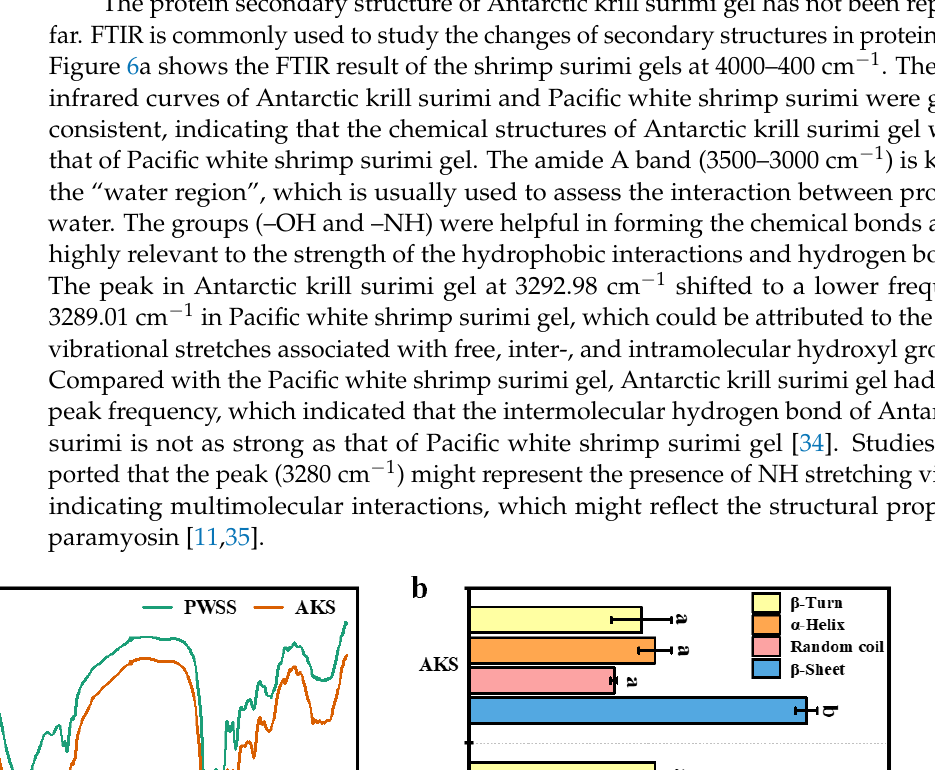
11 of 17 Figure 5. Protein patterns and gray value of Antarctic krill and Pacific white shrimp surimi (gels): ( a ) SDS-PAGE pattern, ( b ) grayscale map; ( c ) gray value of the top of the lane, ( d ) gray value of myosin heavy chain, ( e ) gray value of paramyosin, ( f ) gray value of actin, ( g ) gray value of troponin T, and ( h ) gray value of myosin light chain. AK, Antarctic krill ; AKS, Antarctic krill surimi; PWS, Pacific white shrimp; and PWSS, Pacific white shrimp surimi. Different letters (a–d) indicate significant differences ( p < 0.05). 3.6. Analysis of Protein Secondary Structure in Antarctic Krill Surimi Gel The protein secondary structure of Antarctic krill surimi gel has not been reported so far. FTIR is commonly used to study the changes of secondary structures in protein sys- tems. Figure 6a shows the FTIR result of the shrimp surimi gels at 4000–400 cm − 1 . The trend of infrared curves of Antarctic krill surimi and Pacific white shrimp surimi were